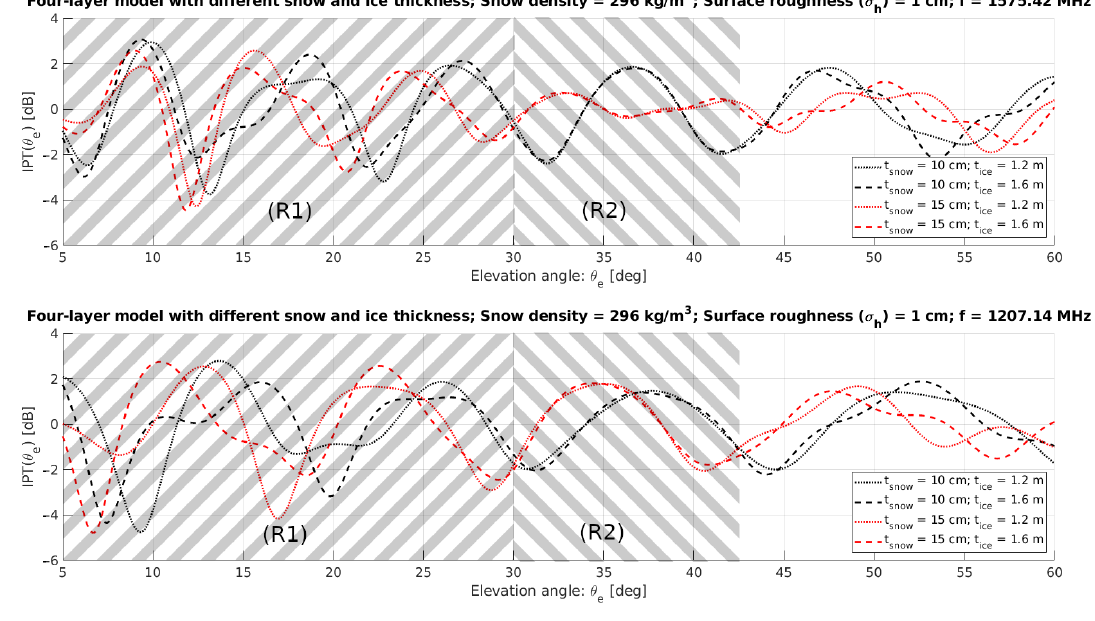
Figure 8. Comparison of the LHCP four-layer model at 1575.42 MHz and 1207.14 MHz, using four different combinations of snow and ice thickness. IPT in region 1 (R1) is affected by ice and snow thickness, while IPT in region 2 (R2) is unaffected by ice-thickness variations.